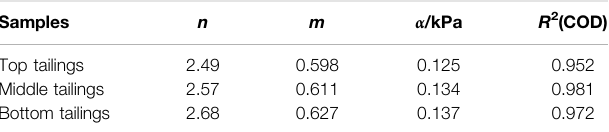
TABLE 3 | Fitting parameters of the Van Genuchten model for the SWCC of tailings at different gradations.